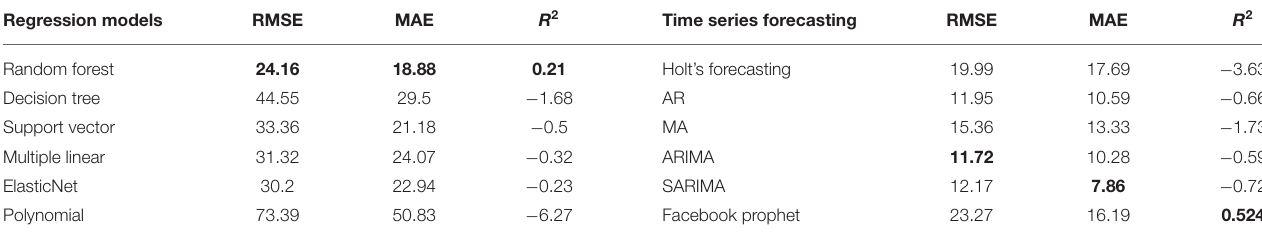
TABLE 7 | Performance metrics comparison table for Nashik.